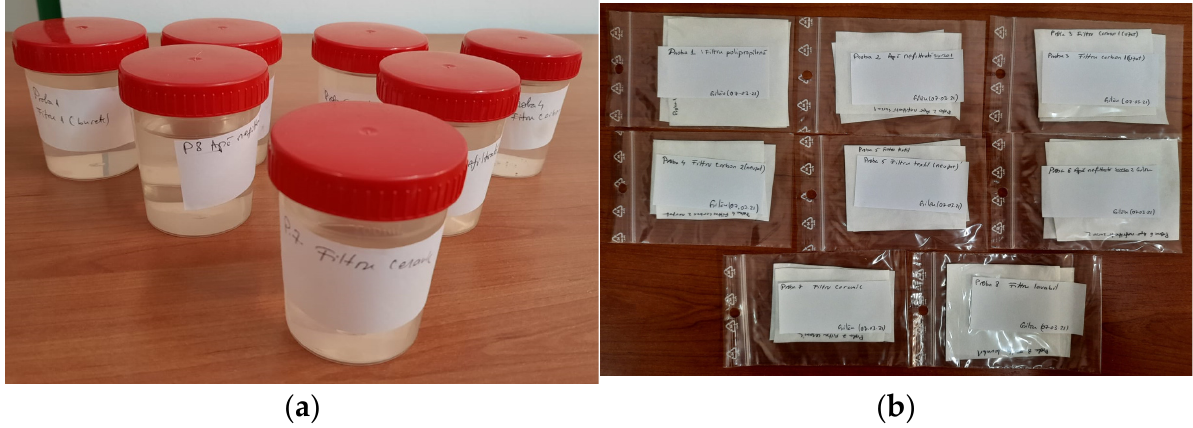
Figure 3. ( a ) Post-filtration water samples; ( b ) samples of impregnated filter paper.